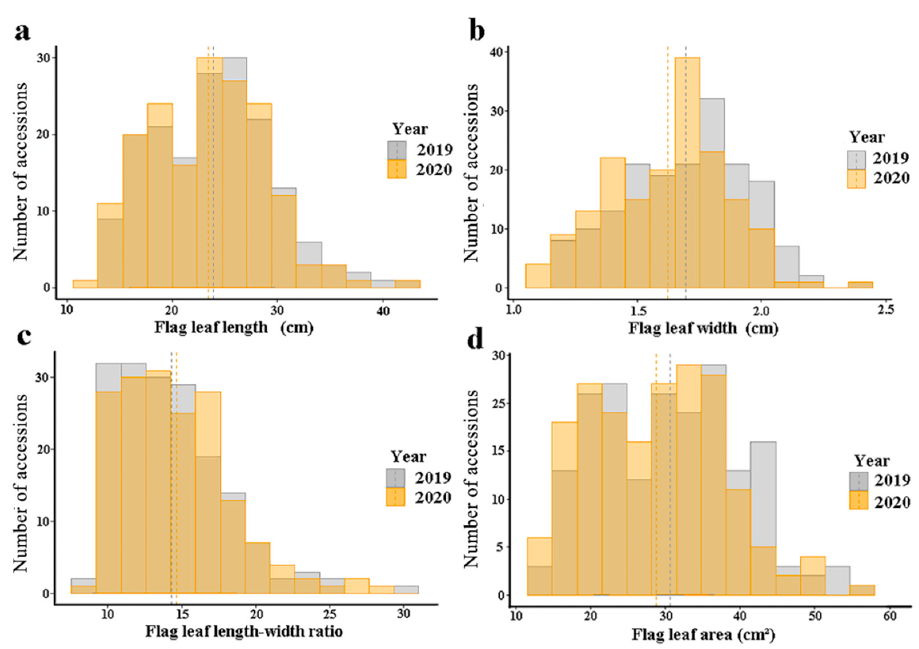
Figure 2. Histogram of the phenotypic frequency distribution of flag leaf shapes in 173 rice accessions: ( a ) Flag leaf length; ( b ) Flag leaf width; ( c ) Flag leaf length–width ratio; and ( d ) Flag leaf area. FLR was negatively correlated with FLW and positively correlated with FLL. FLR had the highest correlations with FLL and FLW, being 0.703 ** and 0.881 **, respectively (Figure 3).